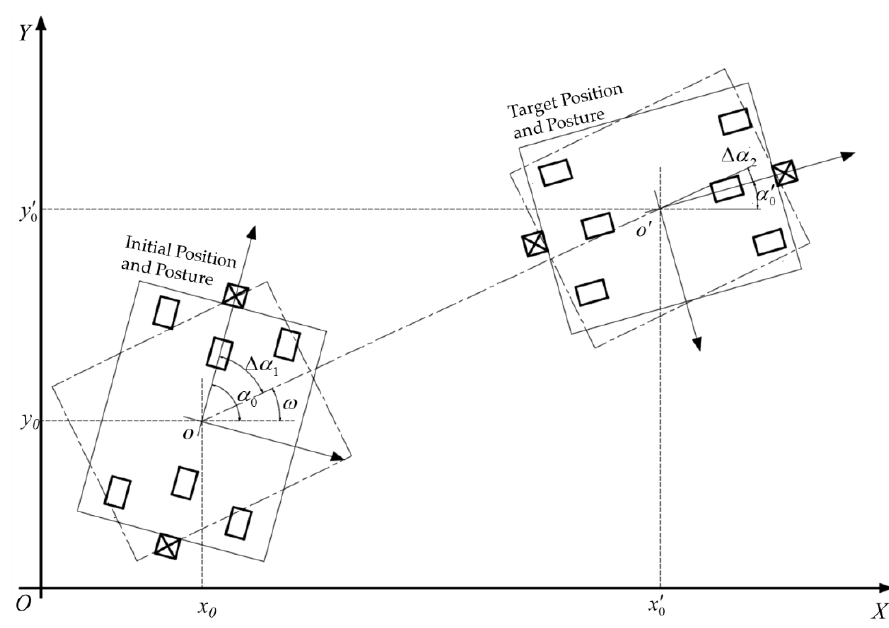
Figure 6. Navigation process in linear motion mode.